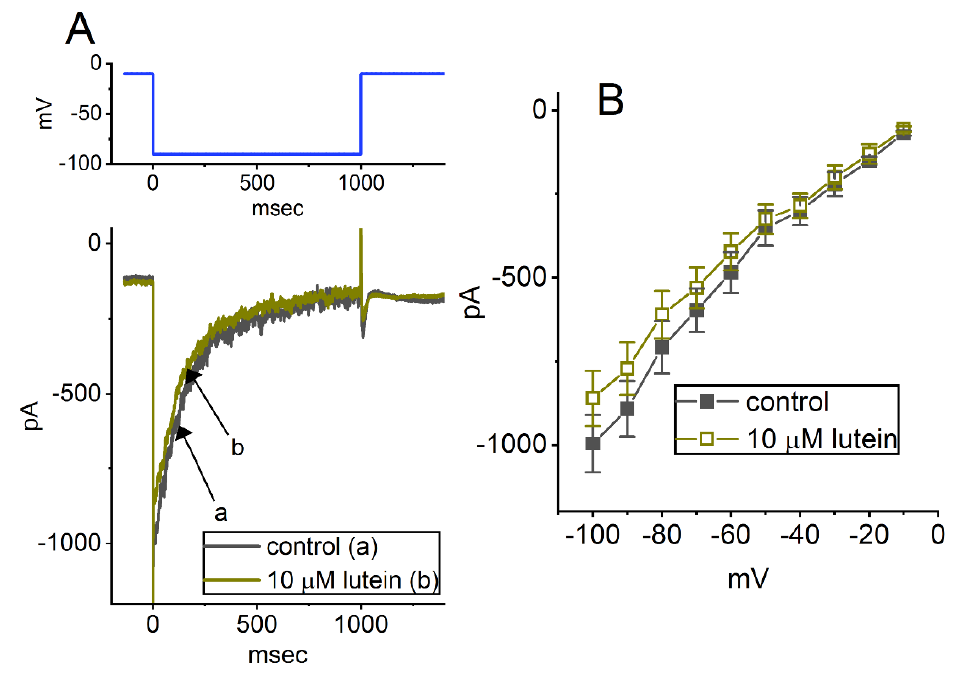
Figure 6. Effect of lutein on erg -mediated K + current ( I K(erg) ) recorded from GH 3 cells. In these experiments of amplifying I K(erg) , we placed cells in high-K + (145 mM), Ca 2+ -free solution, and the recording pipette was filled with K + -containing solution. ( A ) Representative current traces activated by the hyperpolarizing step from −10 to −90 mV (indicated in the upper part, blue color). Current trace labeled a is the control (i.e., lutein was not present, black color), and that labeled b was recorded during the exposure of 10 μM lutein (brown color). ( B ) Average I–V relationship of I K(erg) taken in the absence (filled black squares) and presence (open brown squares) of 10 μM lutein (mean ± SEM; n = 7 for each point). Current amplitude (i.e., deactivating I K(erg) ) was acquired at the beginning of each voltage step from a holding potential of −10 mV.